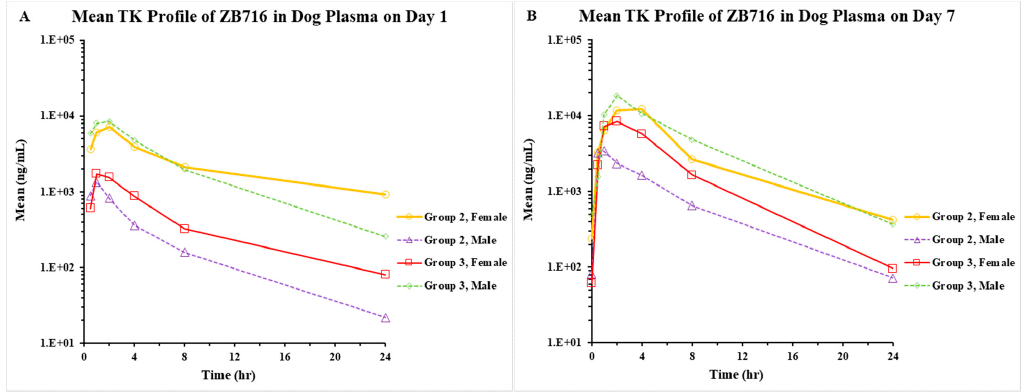
Figure 3. Pharmacokinetic profiles of ZB716 on day 1 ( A ) and day 7 ( B ) in beagle dog plasma. Groups 2 and 3 were given 100 mg/kg/day and 200 mg/kg/day of ZB716, respectively. Table 5. ZB716 repeated-dose PK parameters in beagle dogs.